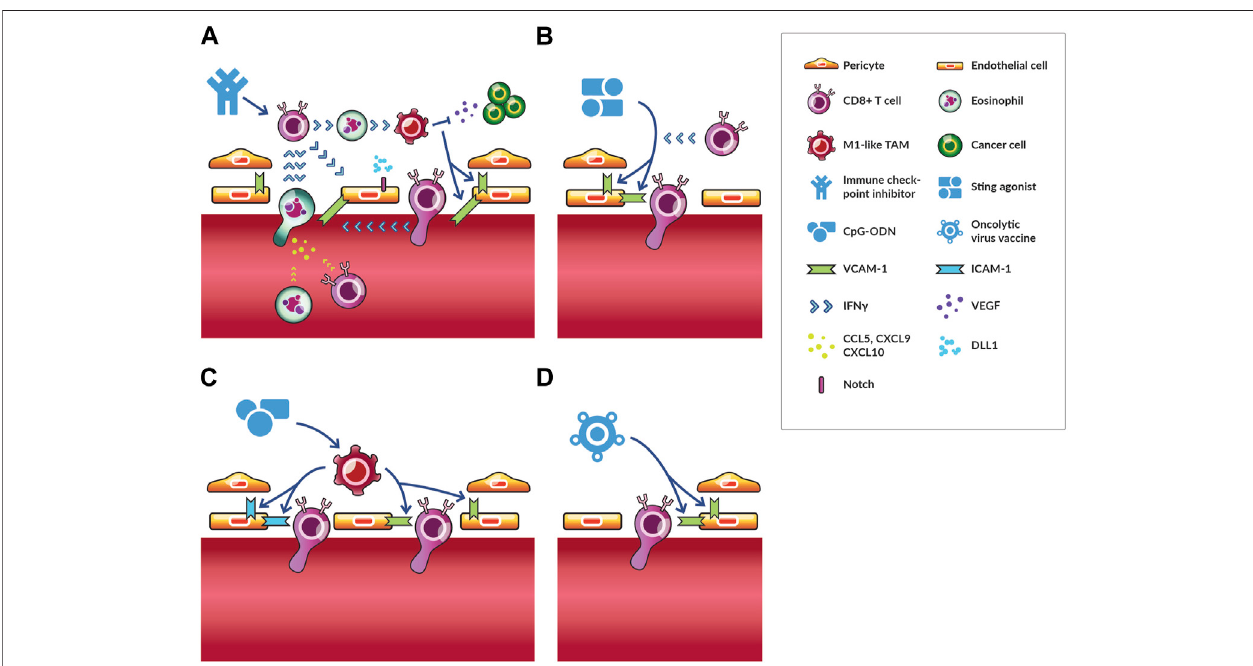
FIGURE 3 | Vascular normalization through immunotherapies. Immunotherapies stimulate various immune cells to act on endothelial and mural cells resulting in vascular normalization. Several immunotherapies normalize vessels through distinct mechanisms. (A) The effects of immune checkpoint inhibitors (ICIs) are the most well-studied. ICIs activate CD8 + T cells, which secrete IFN γ . These cells can interact with activated eosinophils through IFN γ to induce M1-like TAM phenotypes, which reduces VEGF signaling and induces VCAM-1 expression. As a result, more CD8 + T cells and activated eosinophils adhere to and transmigrate across the endothelium. The later secretes chemokines (i.e., CCL5, CXCL9 and CXCL10), which increase traf fi cking of CD8 + T cells and eosinophils to tumors. For this reason, activated eosinophil accumulation precedes and is required for increased CD8 + T cell homing to tumors. This process is a potential feedback loop of vascular normalization and antitumor immunity. DLL1-Notch signaling promotes CD8 + T cell activation and IFN γ production thereby reinforcing this positive feedback loop for long-term vascular normalization. (B) STING agonists cause an increase in antiangiogenic factors, which results in increased pericyte coverage through VCAM-1 expression,whichalsofacilitatesthein fi ltrationofTcells. (C) CpG-ODNdirectlyactonTAMspromotinganM1-likephenotype,whichinducestheupregulationofICAM-1 andVCAM-1expression.Insomecontexts,depletionofregulatoryTcellshassimilareffectsonICAM-1andVCAM-1expression. (D) Oncolyticvaccinesreducevascular density and increase VCAM-1 expression through unelucidated